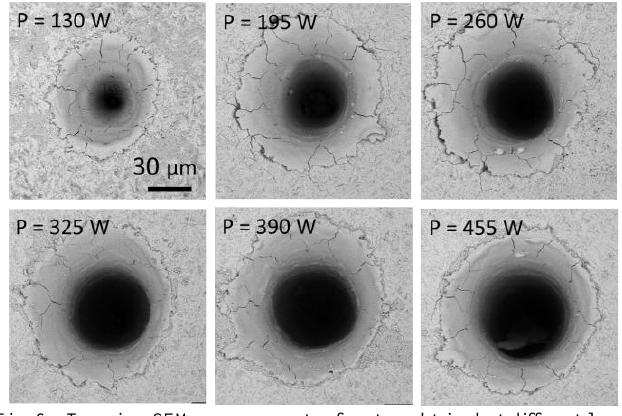
Fig. 6. Top-view SEM measurements of craters obtained at different laser